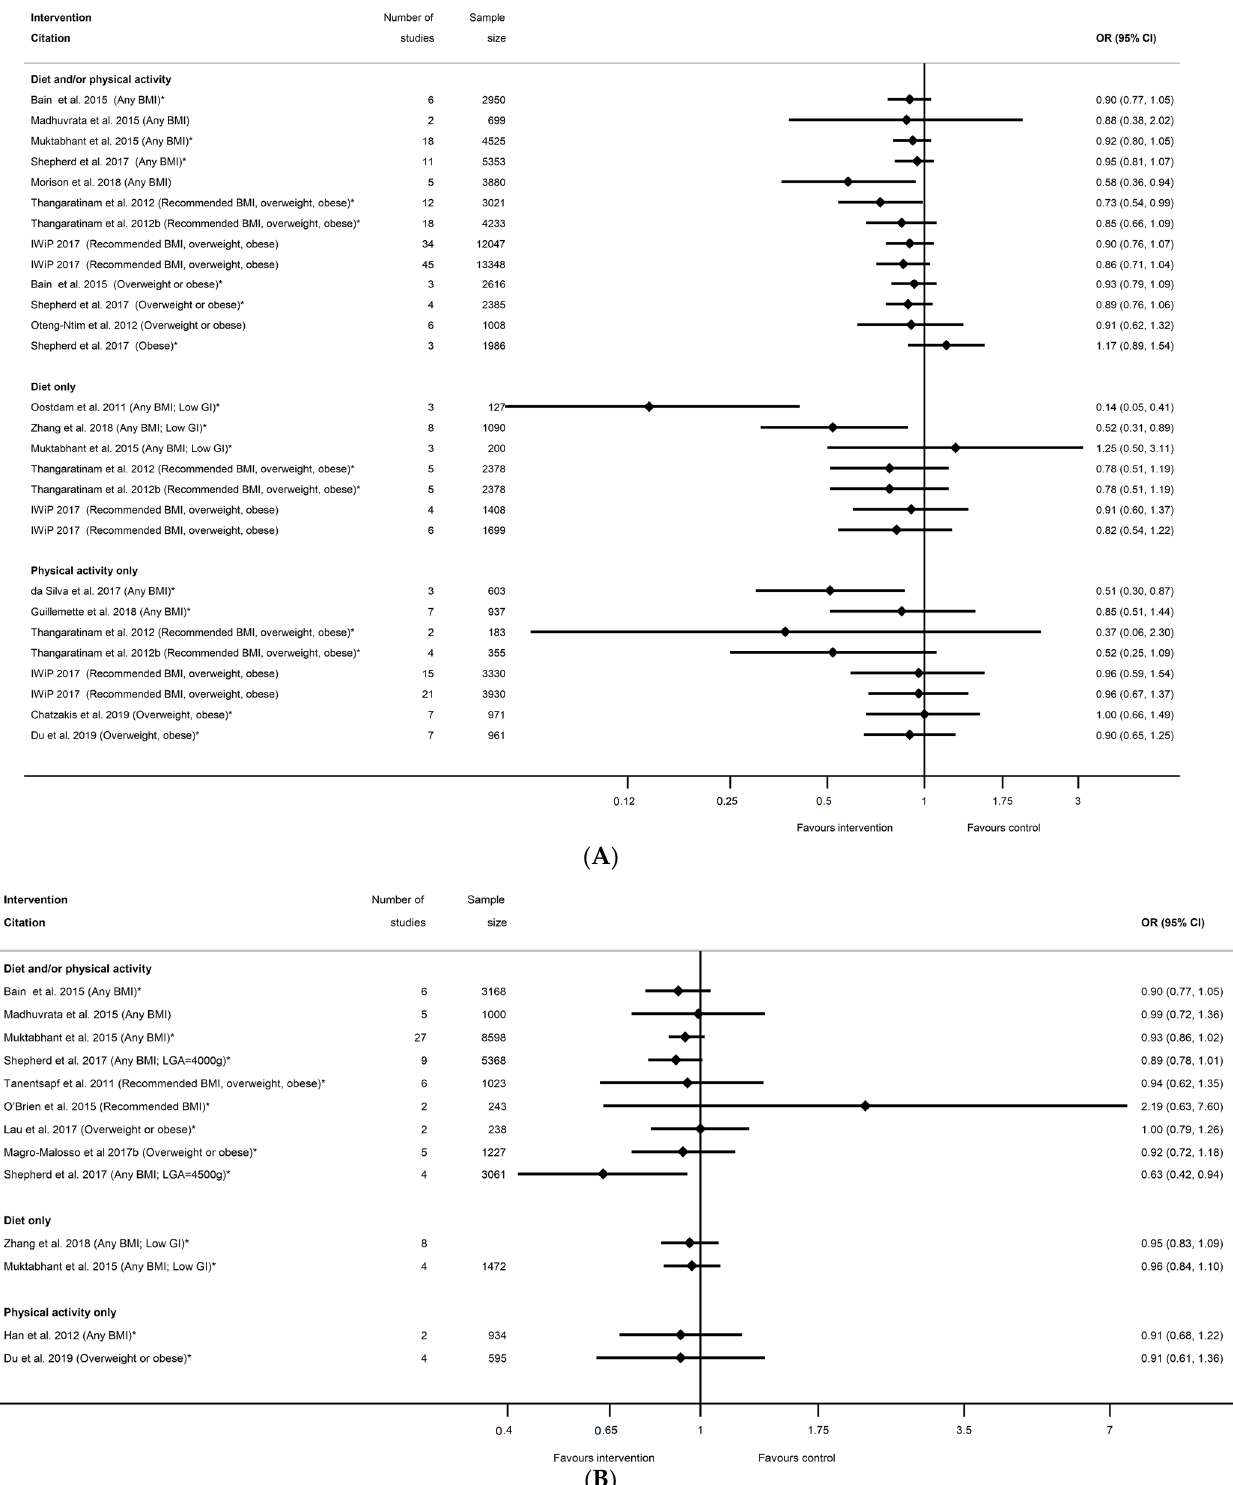
Figure 11. Forest plot of meta-analysis results for high birthweight outcomes; ( A ) LGA, ( B ) macrosomia. * indicates the estimate is relative risk.